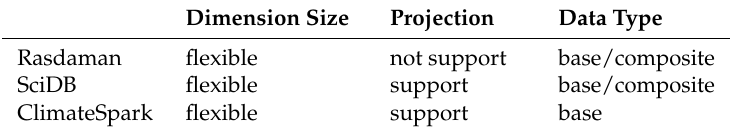
Table 2. The logical data model comparison between Rasdaman, SciDB, and